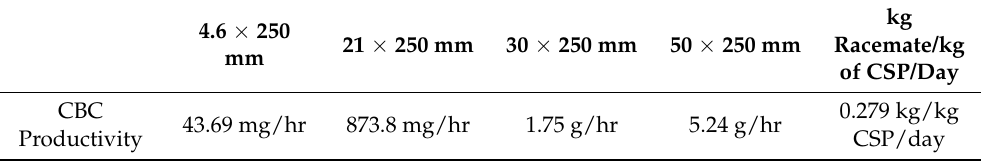
Table 7. Productivity of CBC separation on various column dimensions.